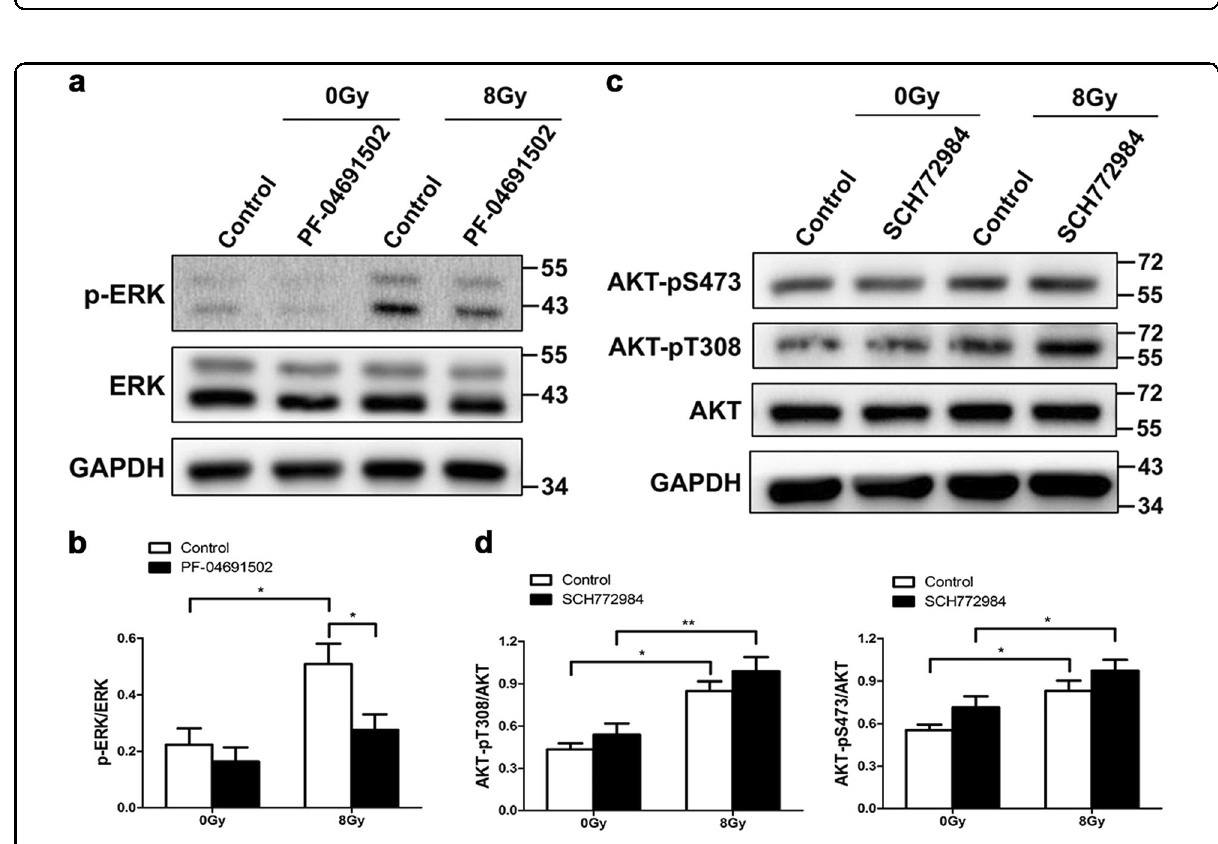
Fig. 6 AKT-mediated ERK signaling is critical for radiation-induced EMT downstream of TBK1. RLE-6TN cells were incubated with/without inhibitor for 2 h before irradiation with 8 Gy. a , b Representative western blot and densitometric quanti fi cation of p-ERK at 3 h postirradiation. GAPDH and ERK were used as loading controls. c , d Representative western blot and densitometric quanti fi cation of AKT-pS473 and AKT-pT308 at 1 h postirradiation. GAPDH and AKT were used as loading controls. All data are presented as the mean ± SEM ( n = 4). One-way ANOVA with Newman – Keuls post hoc analysis was used. * P < 0.05 and ** P <